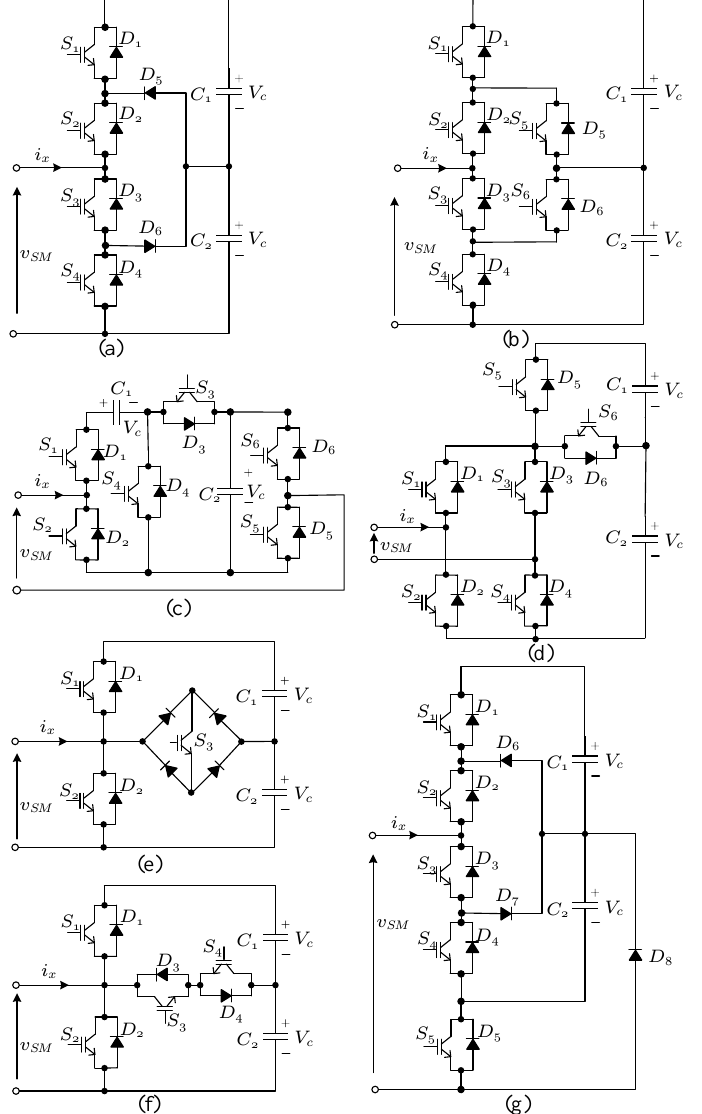
Figure 9. SMs with voltage balancing issues: ( a ) NPC-SM/DC-SM—Neutral point clamped SM/Diode clamped SM; ( b ) ANPC-SM—Active neutral-point clamped unipolar SM; ( c ) CSM-1—Self- blocking composite multilevel SM 1; ( d ) AMSM—Asymmetrical Mixed SM; ( e ) TSM1—T-connected NPC SM 1; ( f ) TSM2—T-connected NPC SM 2; and ( g ) DCMSM—Double clamped diode